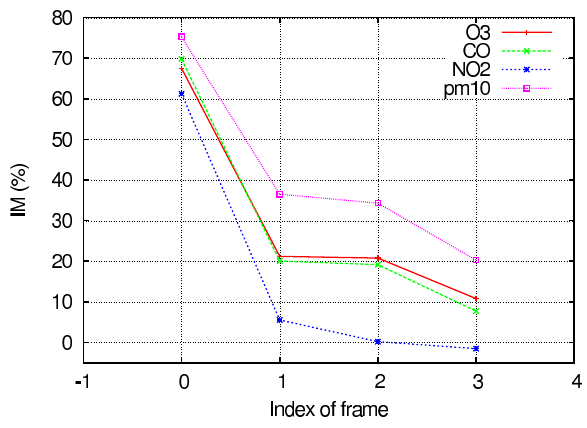
Fig. 6. Daily IM as a function of the frame index for the four se- lected compounds, in the case study 2005-06-17. The Frame index 0 refers to the core region.